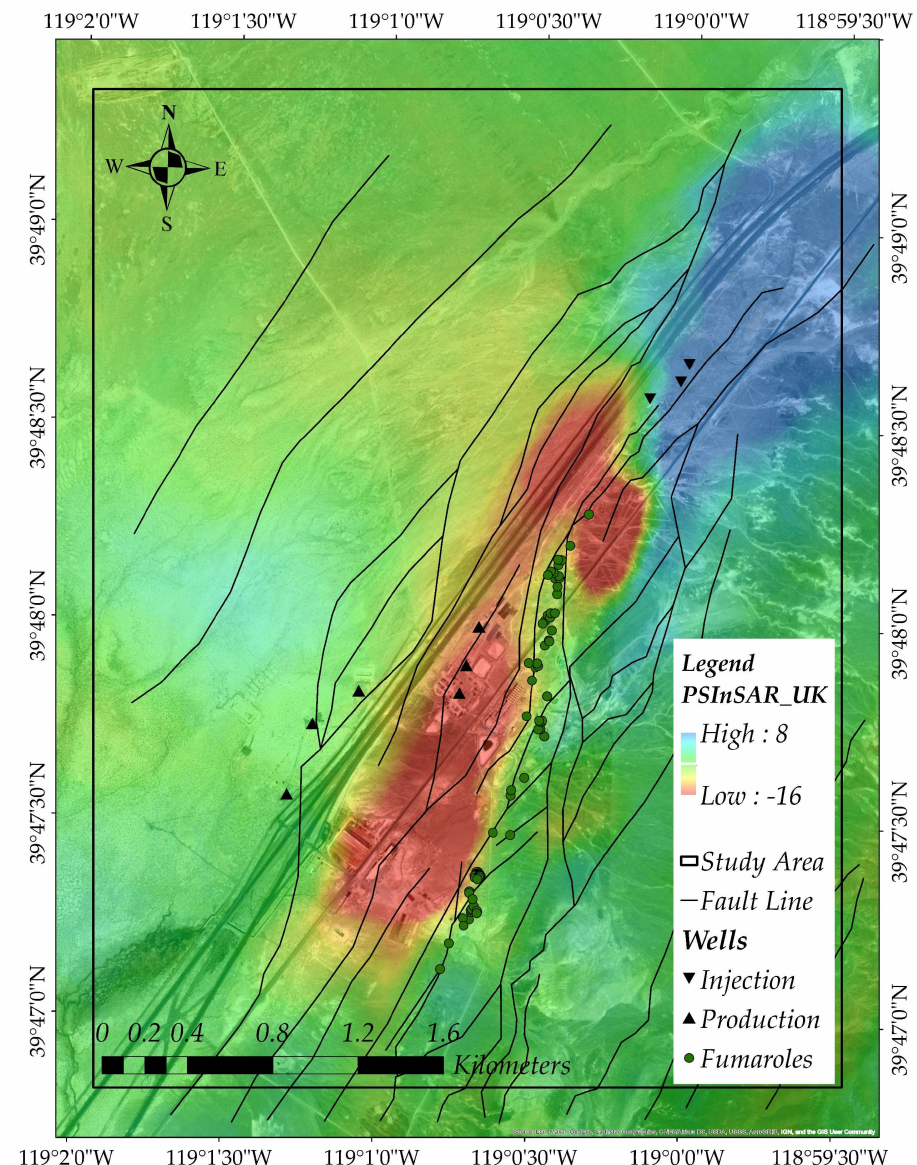
Figure 7. The universal kriging applied to PSI displacement analysis result (PSInSAR_UK: PSIn- SAR_Universal